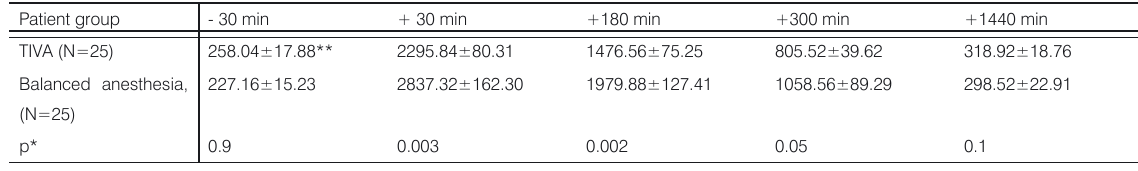
TIVA, total intravenous anesthesia * Mann-Whitney test ** X±SE (for all data in the